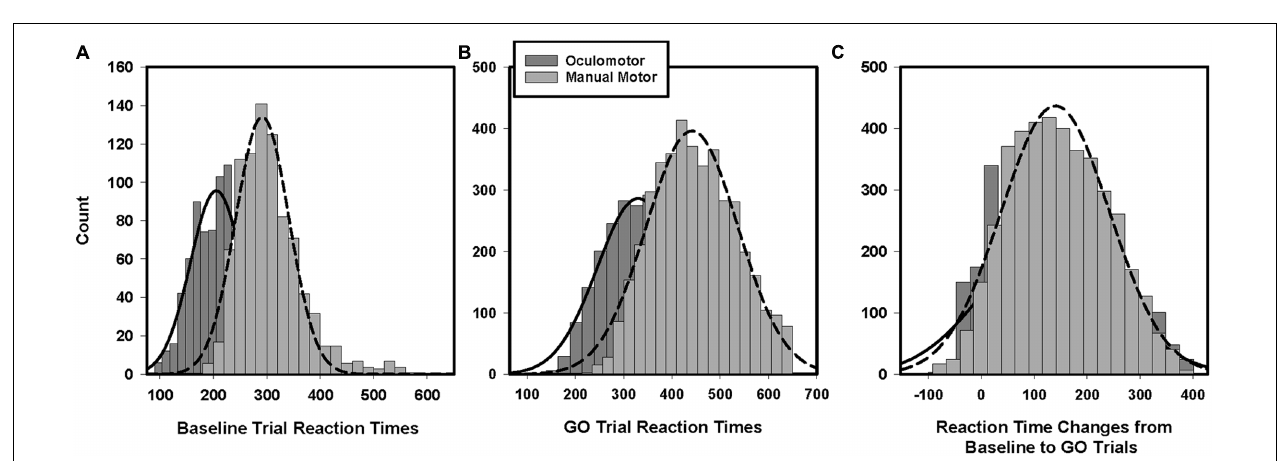
FIGURE 2 | STOP trial accuracy across various Stop Signal Delays during the oculomotor (dashed line) and manual motor (solid line) tasks. Data points represent mean performance across participants at each Stop Signal Delay for the eye (open square) and hand (closed circle). The gray horizontal line is shown to indicate the Stop Signal Delay at which individuals had a 50% probability of accurately inhibiting oculomotor (178 ms) and manual motor responses (227 ms). p 50 values shown here are the means across subjects for each effector.